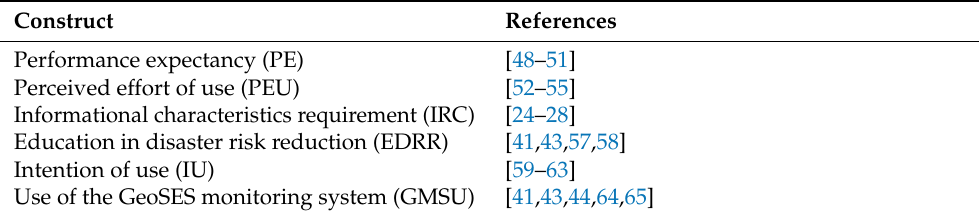
Table 1. Overview of factors of GeoSES model and corresponding references.